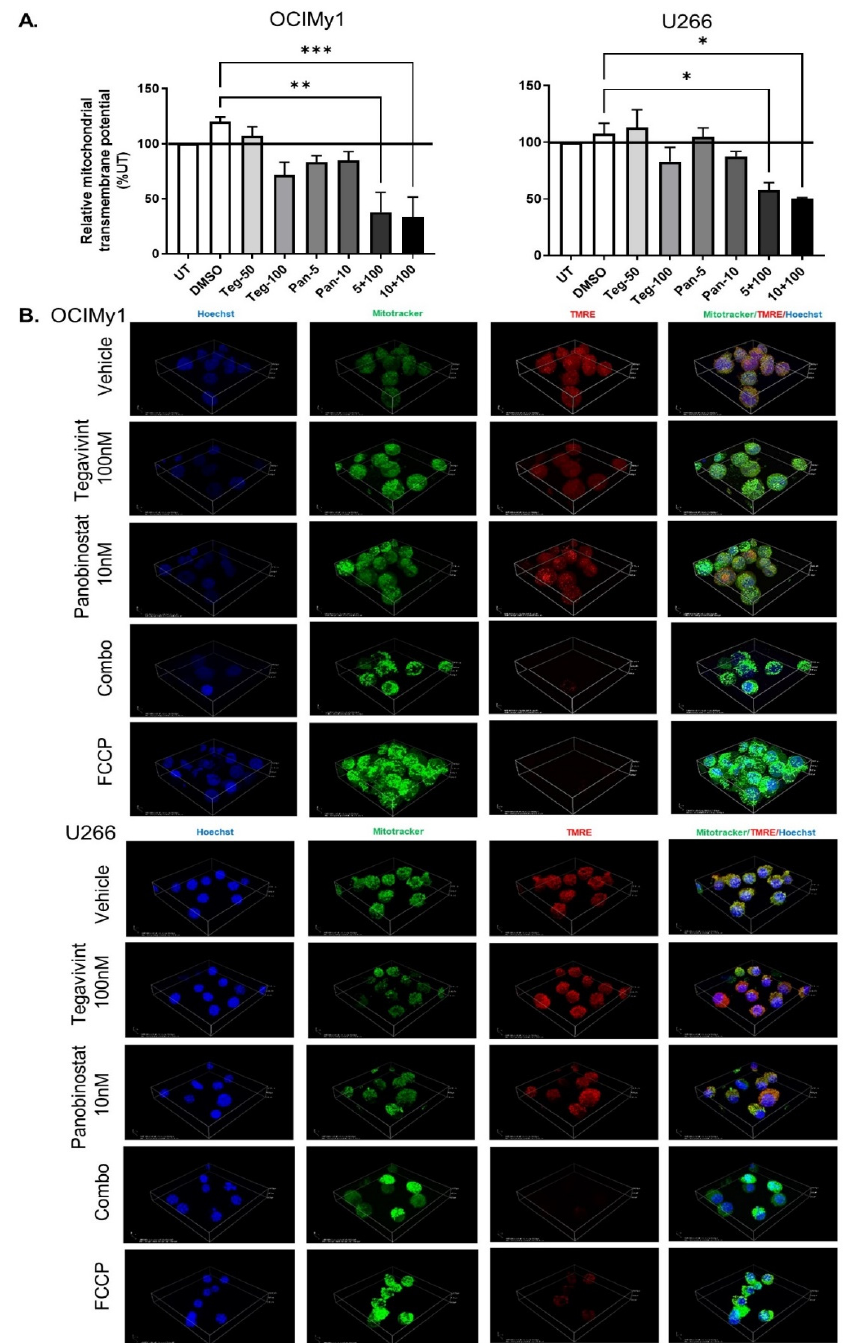
Figure 3. Tegavivint in combination with panobinostat targets mitochondrial fitness of MM cells. ( A ) OCIMy1 and U266 cells were treated with Tegavivint (Teg-), panobinostat (Pan-), Tegavivint and panobinostat, or vehicle (DMSO) for 20 h. Mitochondrial transmembrane potential was measured by TMRE staining and FC. MFI was measured and expressed as a relative % to the TMRE MFI of UT (untreated) cells (UT = 100%) ( n = 3, ± SE, nonparametric Kruskal-Wallis multiple comparisons test, ** p = 0.0013, *** p = 0.001 for OCIMy1, and * p = 0.04 and 0.03 for U266 respectively). ( B ) OCIMy1 and U266 were treated with Tegavivint, panobinostat or the combination for 20 h and stained with TMRE (red for mitochondrial potential), Mito Tracker Green (green for mitochondria) and Hoechst 33,342 (blue for nuclei) and evaluated with confocal microscopy. One µ mol/L of the uncoupling agent FCCP was added 20 min before imaging and used as a positive control (magnification 40 ×